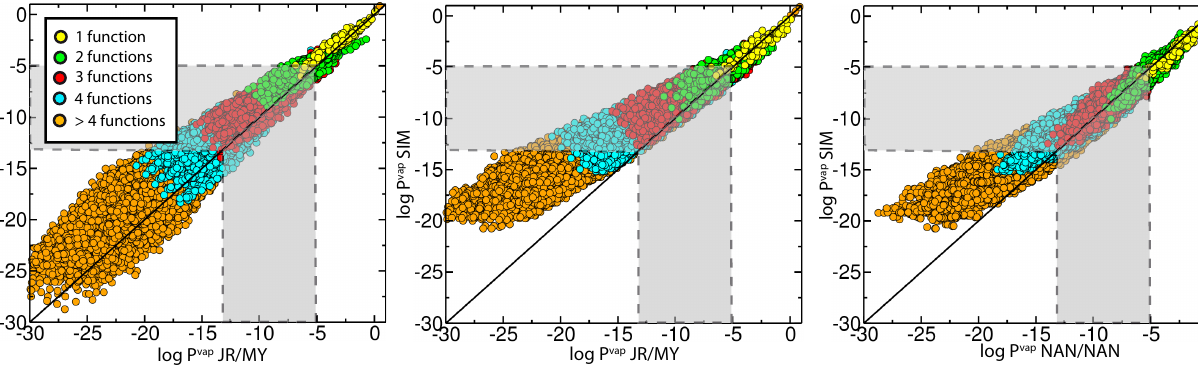
method described by Pankow (1994). No reactions are as- sumed to be occurring in the condensed